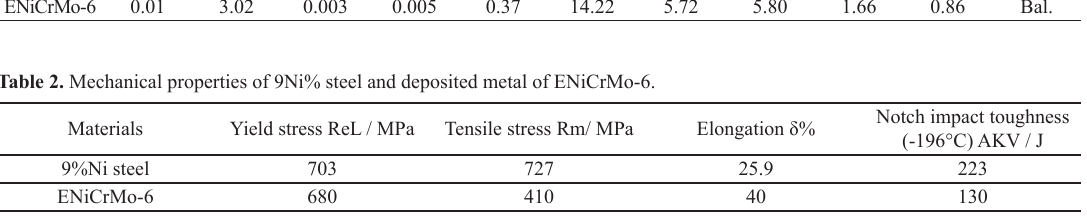
Table 1. Chemical compositions of the 9%Ni steel and deposited metal of ENiCrMo-6(in wt,%). Materials ENiCrMo-6